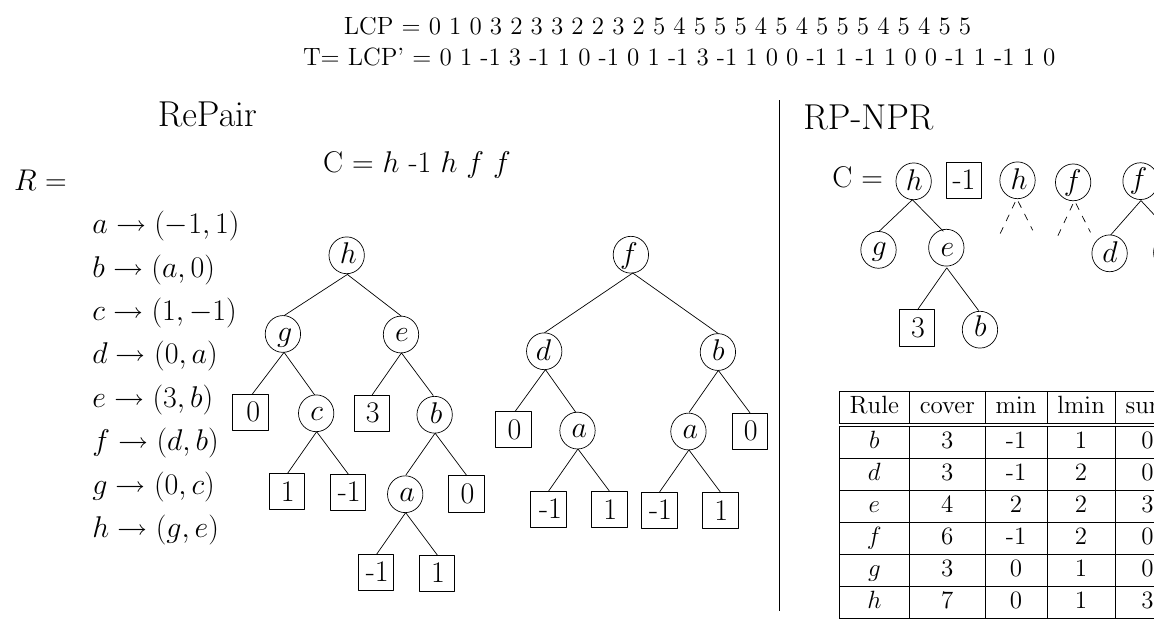
Figure 9. On the left, example of the Re-Pair compression of a sequence T = LCP (cid:48) . We show R in array form and also in tree form. On the right, our RP-NPR construction over T , pruning with t = 4 . We show how deep can the symbols of C be expanded after the